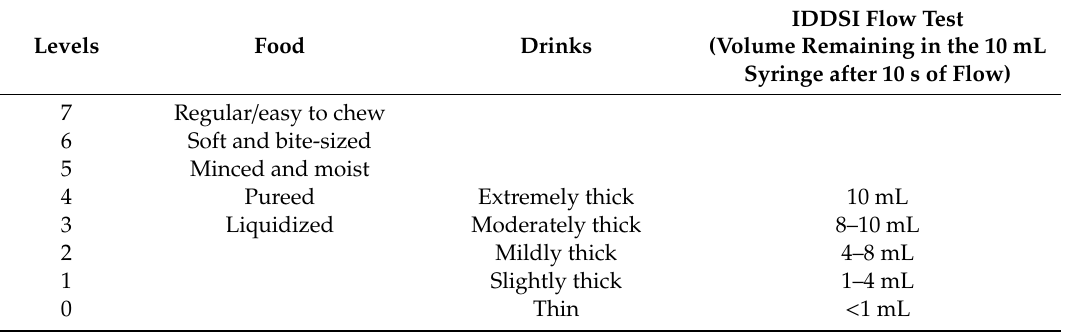
Table 1. International Dysphagia Diet Standardisation Initiative (IDDSI) levels for food and drinks